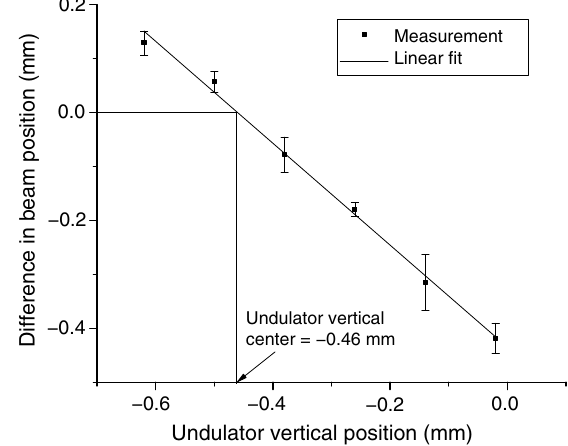
FIG. 66. Example of an undulator alignment scan showing the measured beam positions relative to the reference orbit, Δ y , versus vertical undulator